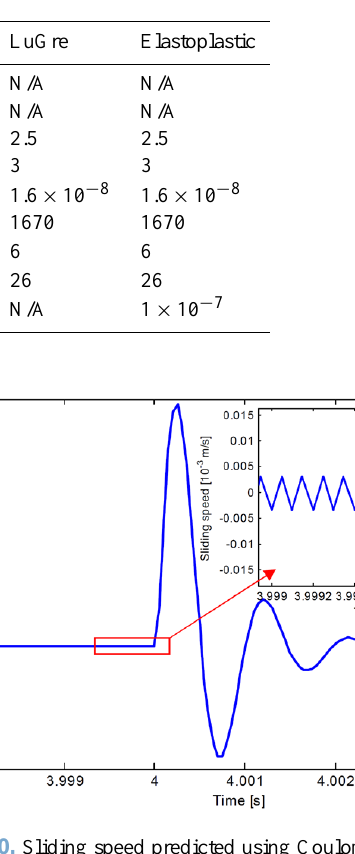
Figure 9. Friction predicted using Coulomb friction model (at around 4th second).